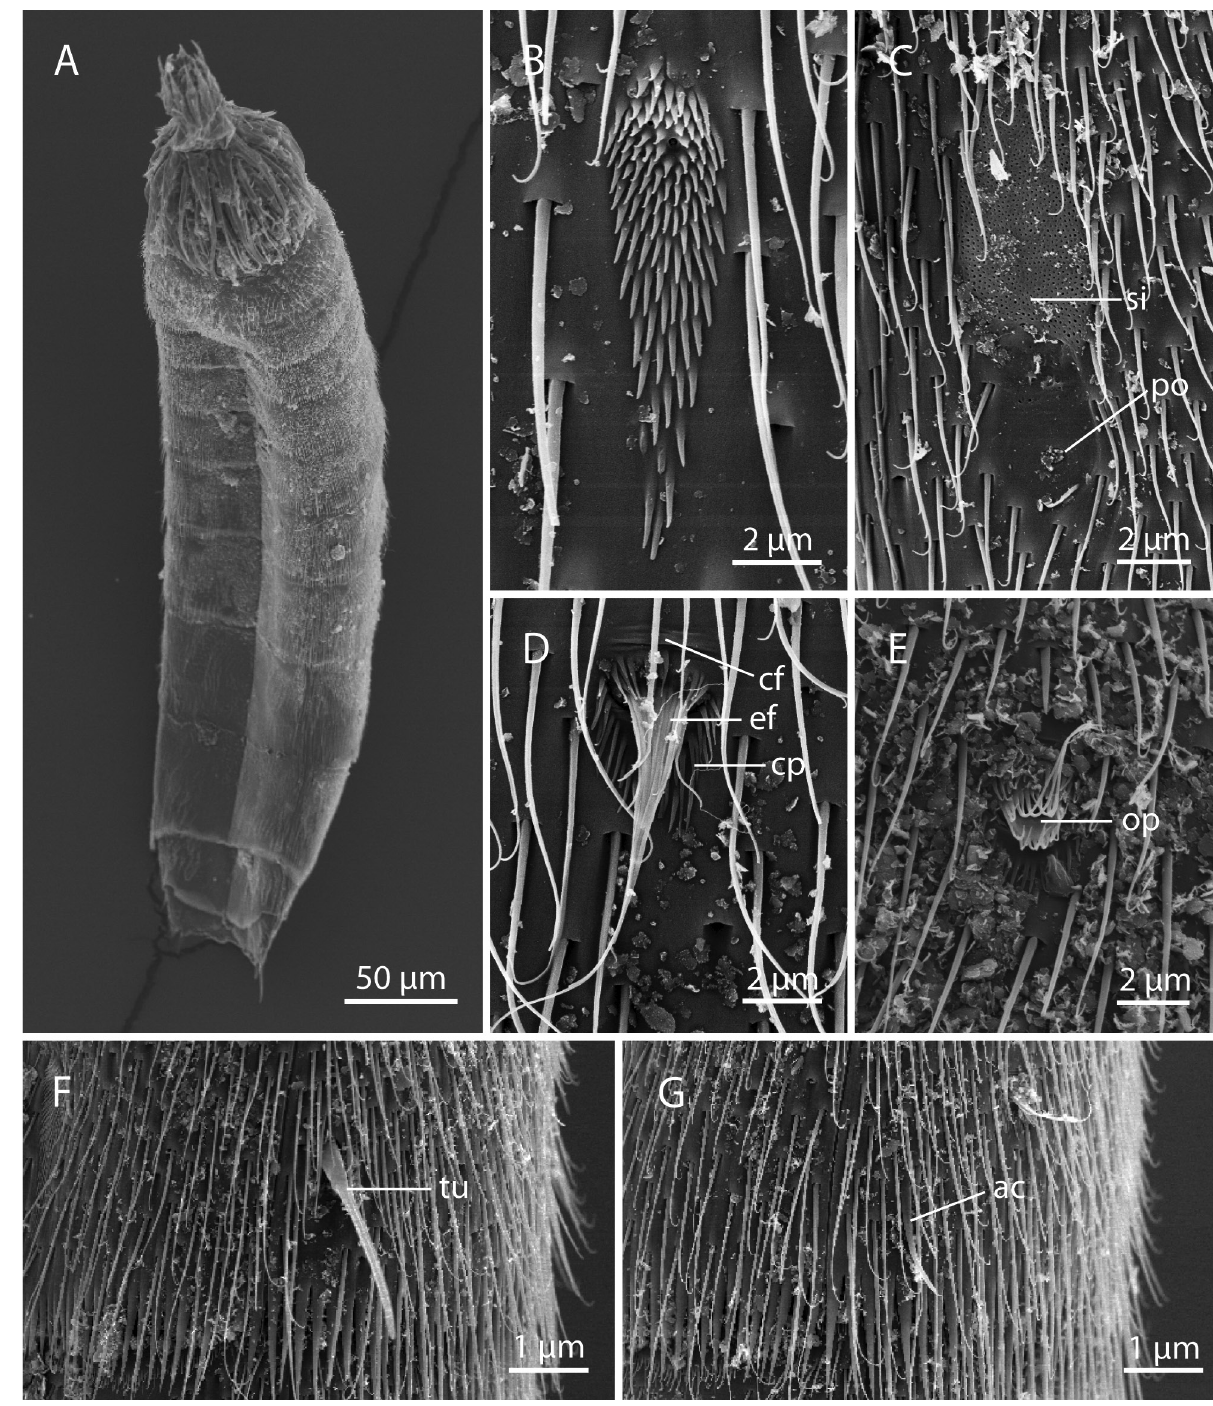
Fig . 1. – Scanning electron micrographs of Echinoderes rex n. sp. A , ventrolateral view; B, detail from segment 7 showing droplet shaped sensory spot as it appears in the ventrolateral positions; C, detail from segment 9 showing sieve plate consisting of an elongated porous plate and a single pore posteriorly; D, detail from midlateral position on segment 8 showing modified glandular cell outlet type II; E, detail from ventrolateral position on segment 2 showing modified glandular cell outlet type II; F, detail from segment 5 showing lateroventral tubule; G, detail from segment 6 showing lateroventral acicular spine. Abbreviations: ac, acicular spines; cf, cuticular furrows; cp, cuticular papillae; ef, elongated fringes; op, opening; po, pore; si, sieve plate; tu,